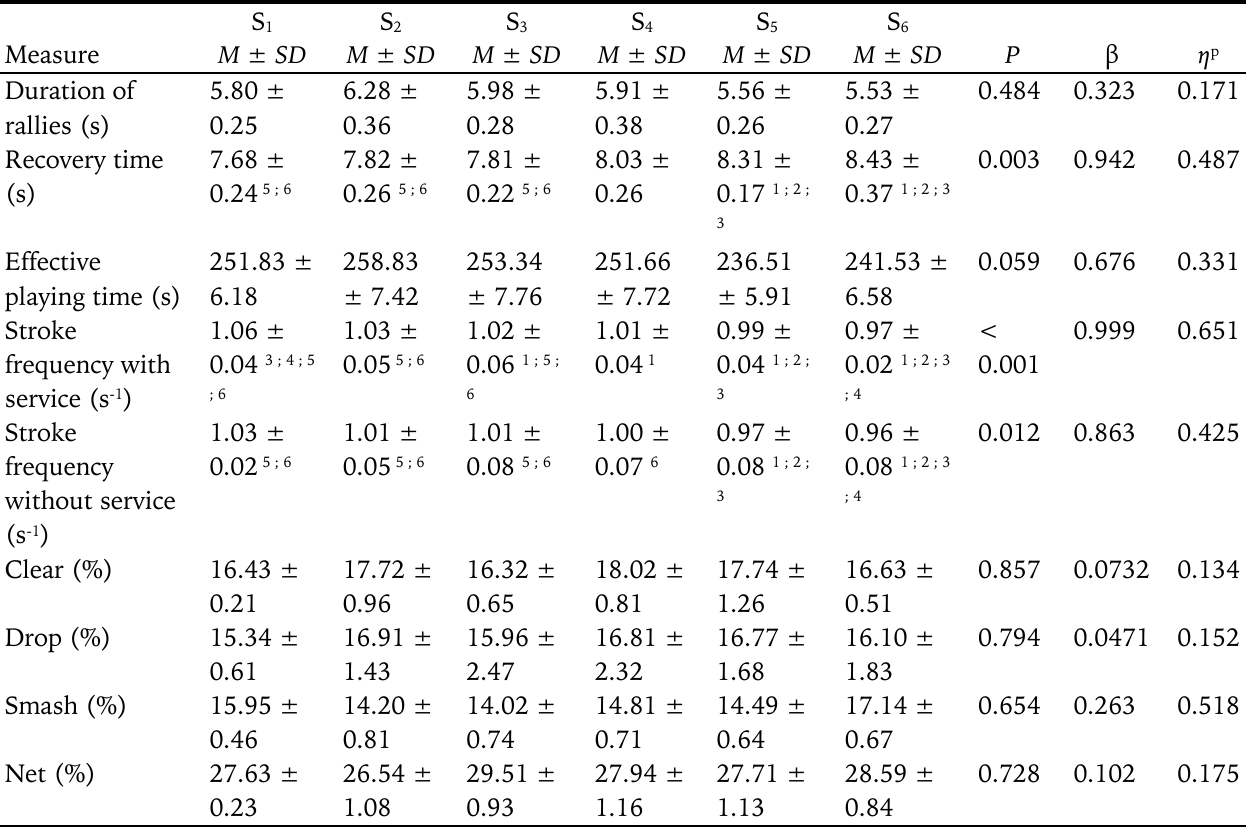
Temporal and notational variables during each test session at S 1 : 10 th min; S 2 : 20 th min; S 3 : 30 th min; S 4 : 40 th min; S 5 : 50 th min and S 6 : 60 th min of badminton playing